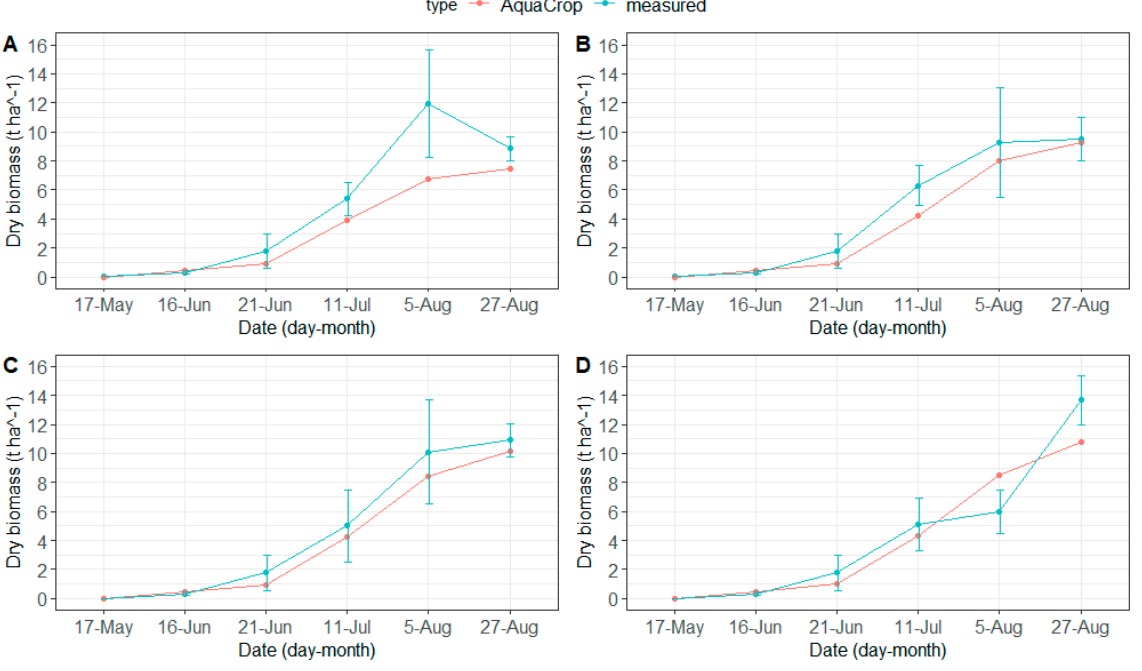
Figure 3. Simulated and measured biomass values for the 2019 growing season (validation). Error bars represent the standard deviation (n = 4). The ( A – D ) letters refer to the K, I50, I75, and I100 treatments, respectively.